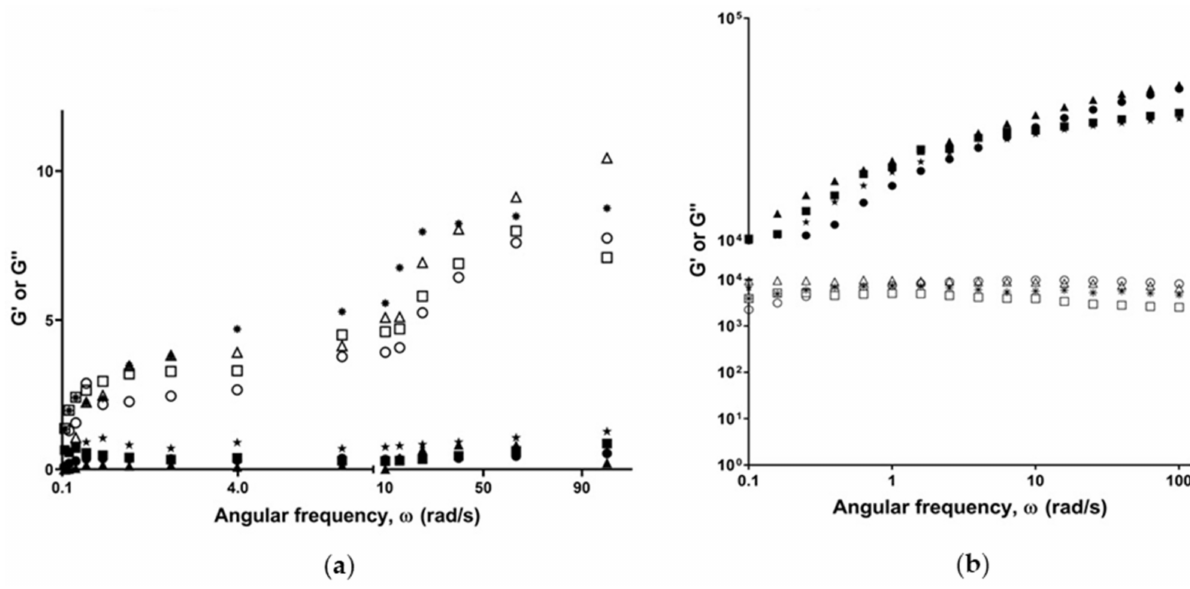
Figure 1. Frequency sweep measuring storage/elastic (G’) and loss/viscous (G”) moduli as a function of angular frequency ( ω ) at ( a ) 20 ◦ C and ( b ) 37 ◦ C. G’ represented as filled symbols and G” as unfilled symbols. The formulations represented as LF10/poloxamer (*), LF50/poloxamer ( (cid:4) ), LF100/poloxamer ( • ) and LF200/poloxamer ( (cid:78)